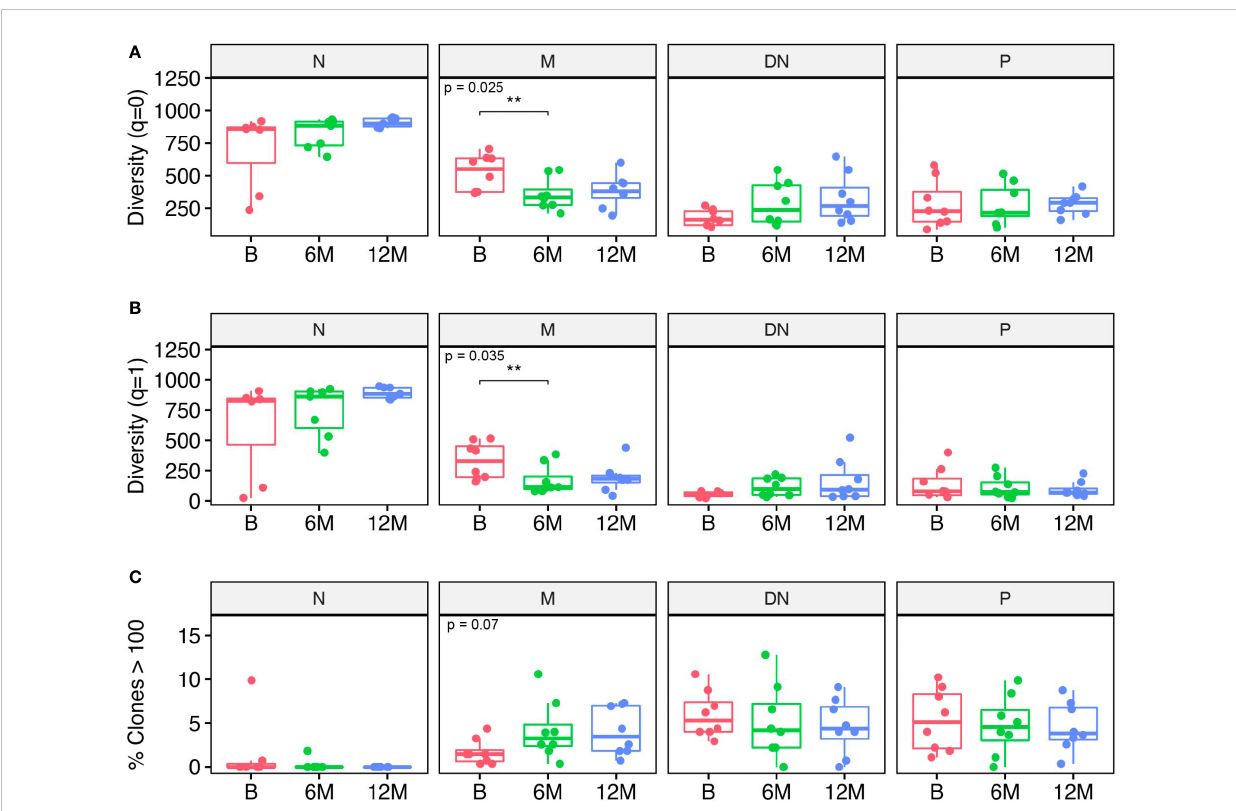
FIGURE 2 Clonal analysis of B cell repertoires for each B cell subset including naive (N), memory (M), double negative (DN) B cells and in plasmablasts (P) at baseline (B), 6 months (6M) and 12 months (12M) following cladribine treatment. (A) Clonal diversity expressed as Hill numbers for q=0. This corresponds to the total number of clones for each B cell subset and time-point. (B) Clonal diversity expressed as Hill numbers for q=1, which takes into account the number of clones and their proportions in the repertoire. (C) Percentage of clones comprising more than 100 retrieved sequences/ clone. Diversity values were obtained on a bootstrap sample of n = 951 sequences with 200 repetitions. P values show Kruskal-Wallis multi-group comparison tests. Asterisks denote Wilcoxon Rank-Sum paired tests performed if Kruskal-Wallis tests were signi fi cant